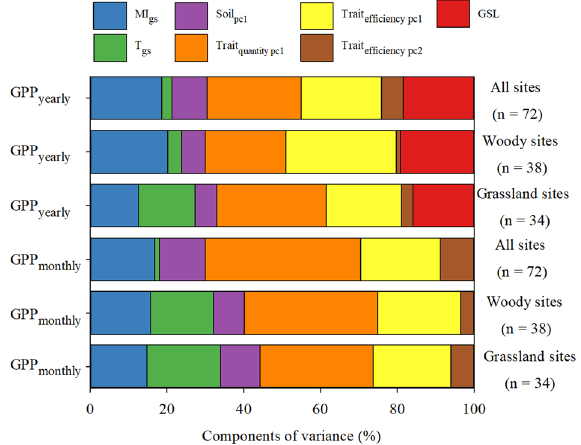
Fig. 5 Variance partitioning of the independent-effects analysis applied to the annual and monthly gross primary productivity (GPP yearly and GPP monthly ) models. GPP yearly : yearly GPP model (GPP yearly ~ MI gs + T gs + Soil pc1 + Trait quantity + Trait ef fi ciency + GSL). GPP monthly : monthly GPP model (GPP monthly ~ MI gs + T gs + Soil pc1 + Trait quantity + Trait ef fi ciency ). PC 1 and PC 2: fi rst two principal components (PCs) of the corresponding factors; Trait quantity and Trait ef fi ciency : quantity and ef fi ciency traits, respectively; GSL: growing season length (months). MI gs and T gs : growing season moisture index and temperature, respectively. n values in brackets: number of observations for the corresponding